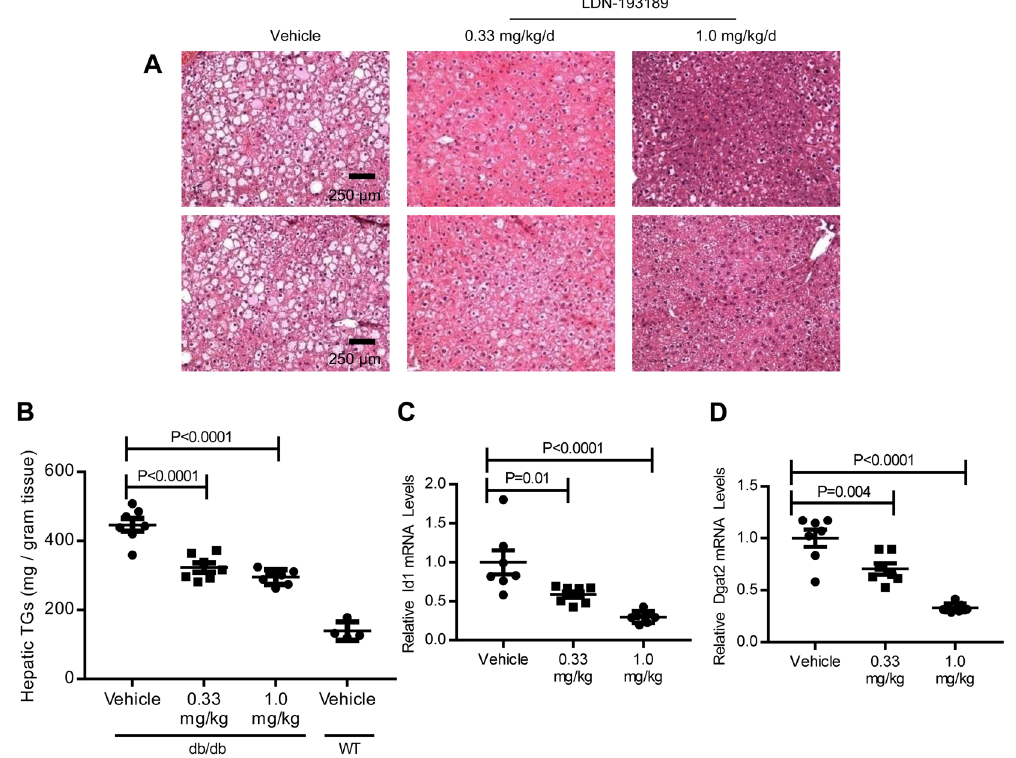
Figure 1. Pharmacologic inhibition of BMP signaling with LDN-193189 reduces hepatic steatosis. Representative photomicrographs of liver sections from leptin receptor-deficient ( db/db ) mice treated with vehicle or the BMP inhibitor LDN-193189 for 14 days beginning at 4 weeks of age. Sections were stained with hematoxylin and eosin ( A ). LDN-193189 treatment reduced hepatic tissue triglyceride (TG) toward wild-type (WT) levels ( B ). Treatment of db/db mice with LDN-193189 reduced hepatic BMP signaling as measured by inhibitor of DNA binding 1 (Id1) mRNA levels and was associated with reduced diacylglycerol O-acyltransferase 2 (Dgat2) mRNA levels ( C , D respectively). There were seven replicates per treatment group. Comparisons were performed using 1-way ANOVA with Sidak’s multiple comparison testing. Scale bars represent 250 µ m and apply to all six